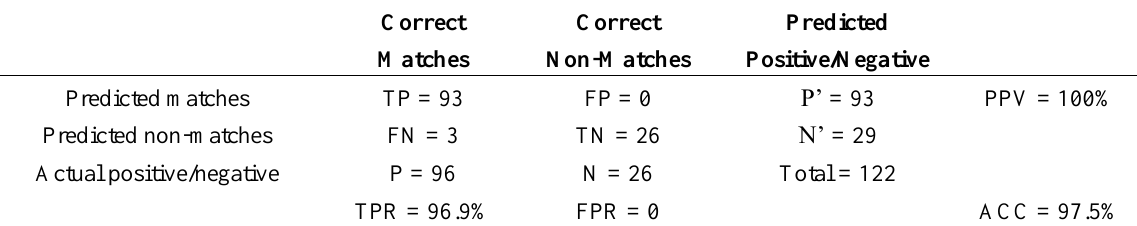
Table 3. Confusion matrix and common performance metrics calculated from façade matching.